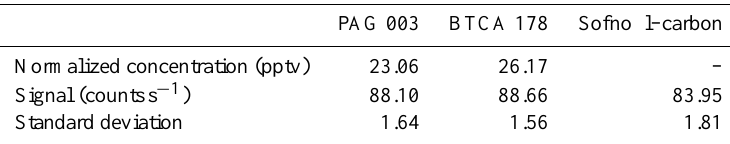
Table 1. Comparison of the NO 2 observed from measurement of three zero-air sources (Eco Physics AG PAG 003, BOC speciality gases BTCA 178, and Sofnofil–carbon–13 × molecular sieve filters) by LIF. The average of ten 1min averages is shown in pptv, normalized to the lowest reading, in raw PMT countss − 1 as well as the standard deviation of those